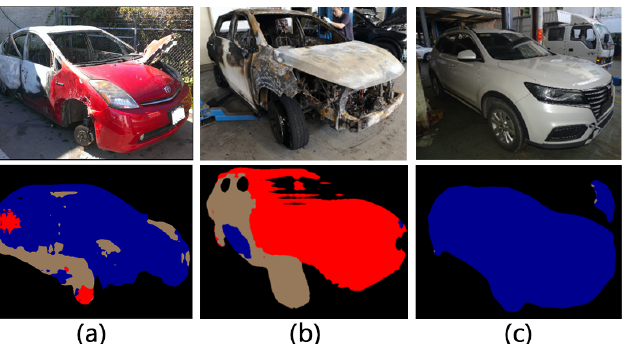
Figure 11. Limitations of the model. ( a ) Error of a red vehicle. ( b ) Gridding. ( c ) FP area from other